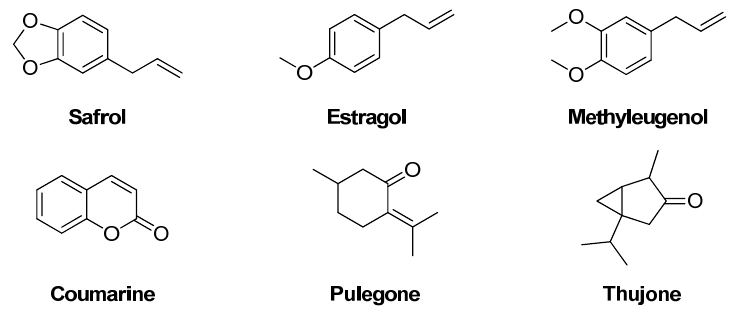
Figure 2. Chemicals from natural extracts in the spotlight for human